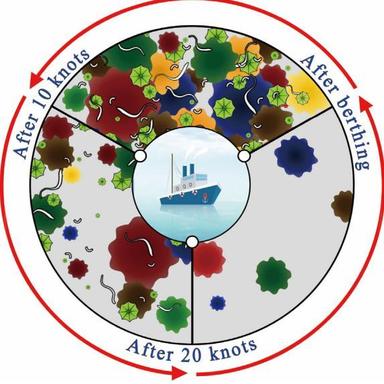
Self-cleaning schematic of the fouling release coatings. Copyright © 2012, American Chemical Society.